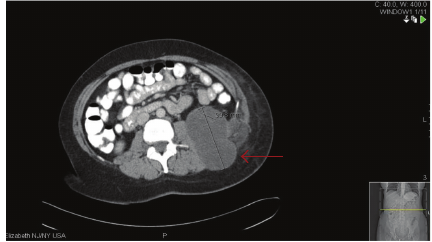
Figure 4: Red arrow pointing to the cystic component of the soft tissue mass with its